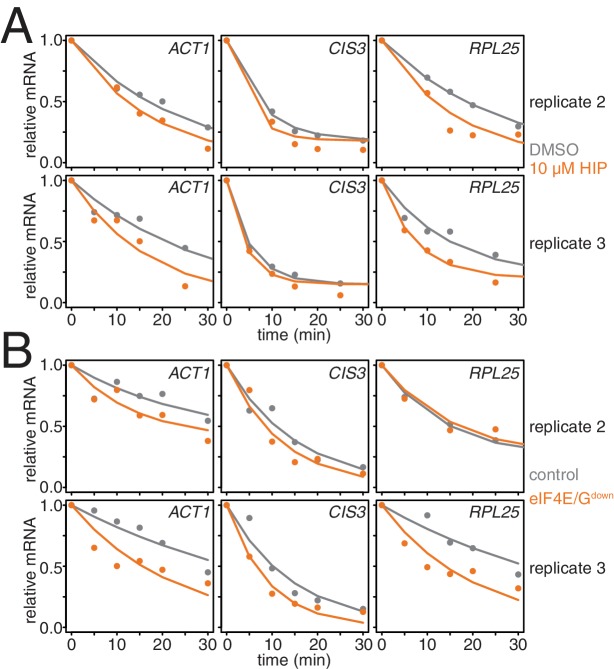
Characterization of conditional mutants of translation initiation.(A) Two additional biological replicates of the experiment described in Figure 3I. (B) Two additional biological replicates of the experiment described in Figure 3J.